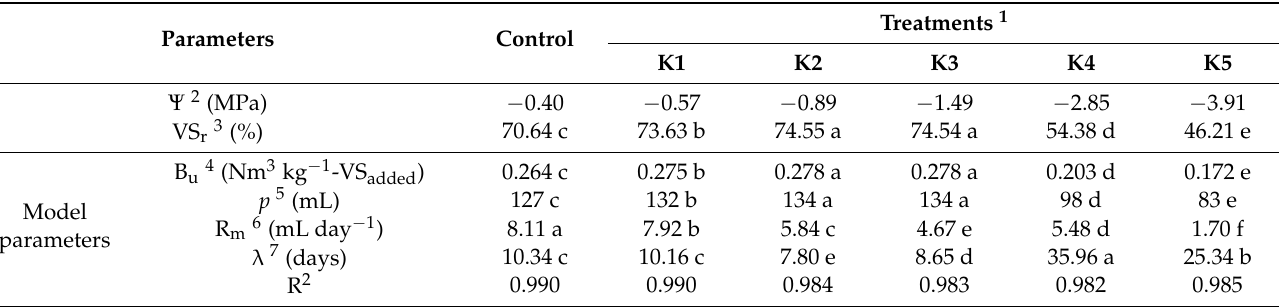
Table 7. Ultimate methane yield and the parameters calculated with the modified Gompertz model for the water potential ( Ψ ) inhibition assay.